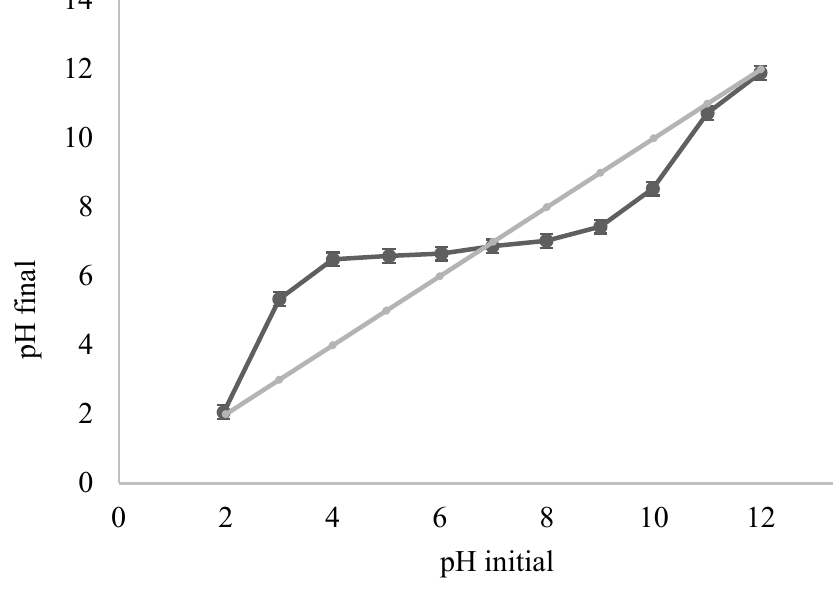
Figure 5. pH pzc determination of ACOC.